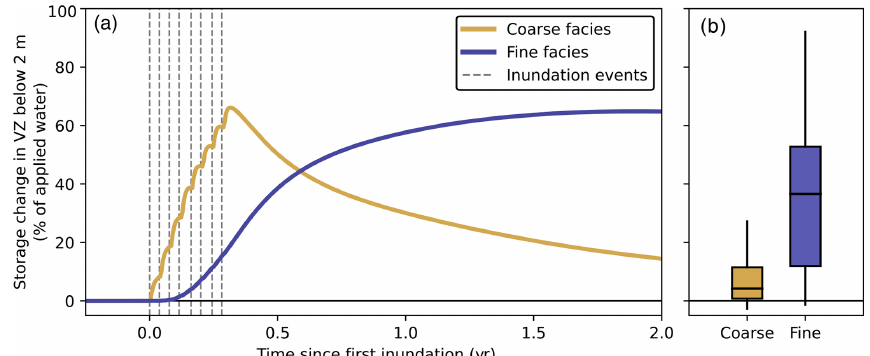
Figure 8. Storage change in the vadose zone (VZ) below 2m (a) for a simulation with low saturated-zone recharge efficiency (8.7% after 2 years). The percent change in vadose-zone storage at 2 years for all 284 simulations is shown as a box plot in panel (b) . Results of the paired t test indicate that the difference in the two populations in panel (b) is statistically significant ( P < 0 . 001). In both subplots, coarse facies (yellow) are defined as any model cells with coarse fraction ≥ 0.5; fine facies (blue) correspond to coarse fraction < 0.5.